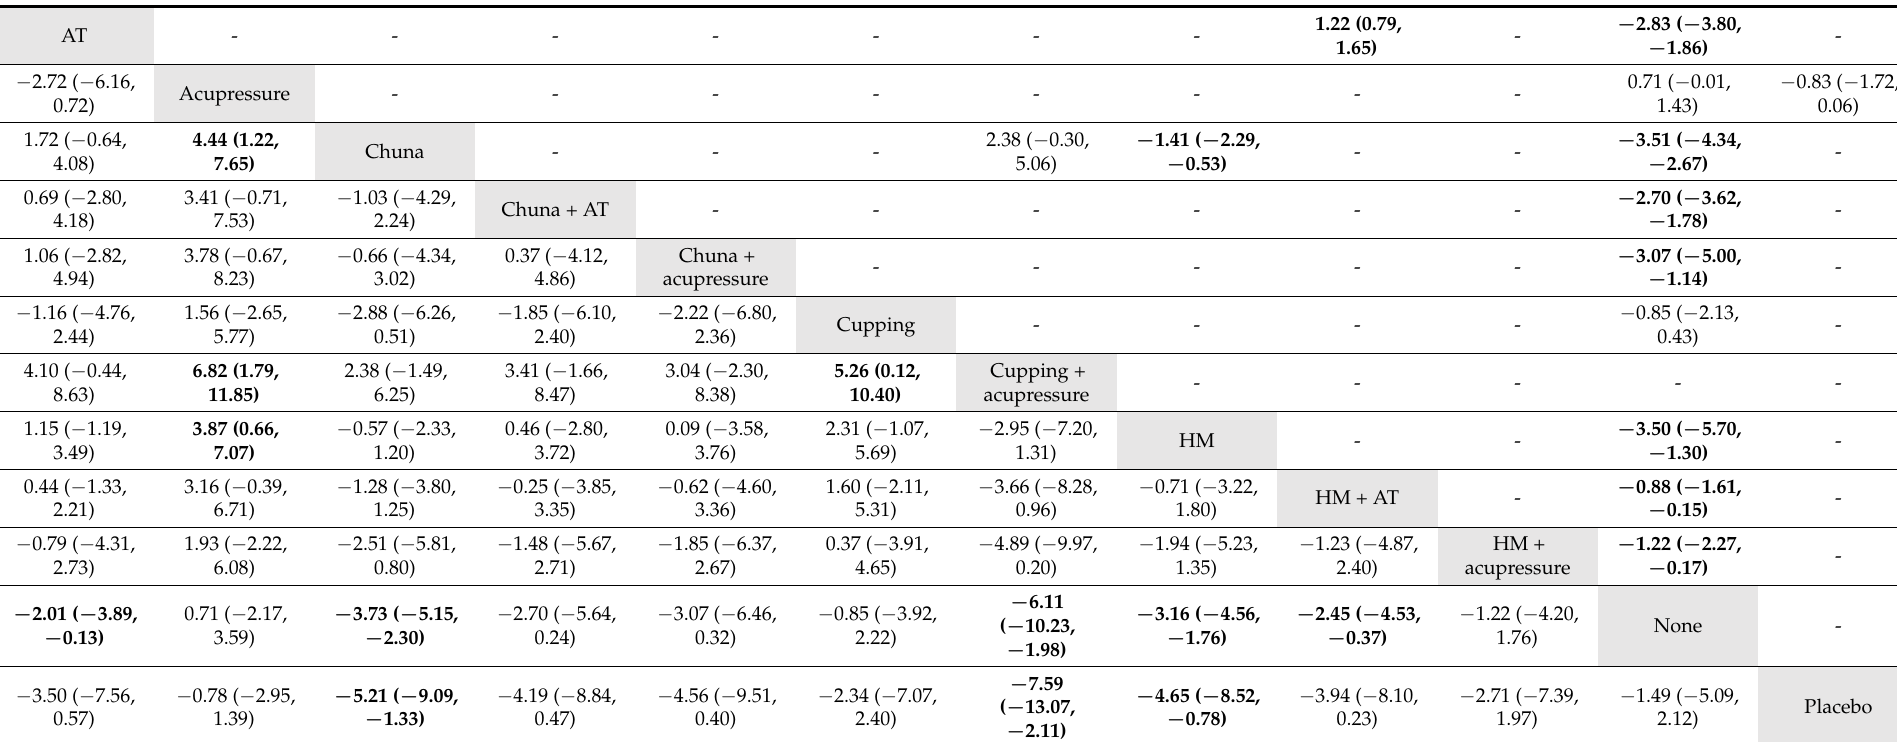
Table 1. League table for pairwise meta-analysis (right upper part) and NMA (left lower part) effect estimates: body mass index.